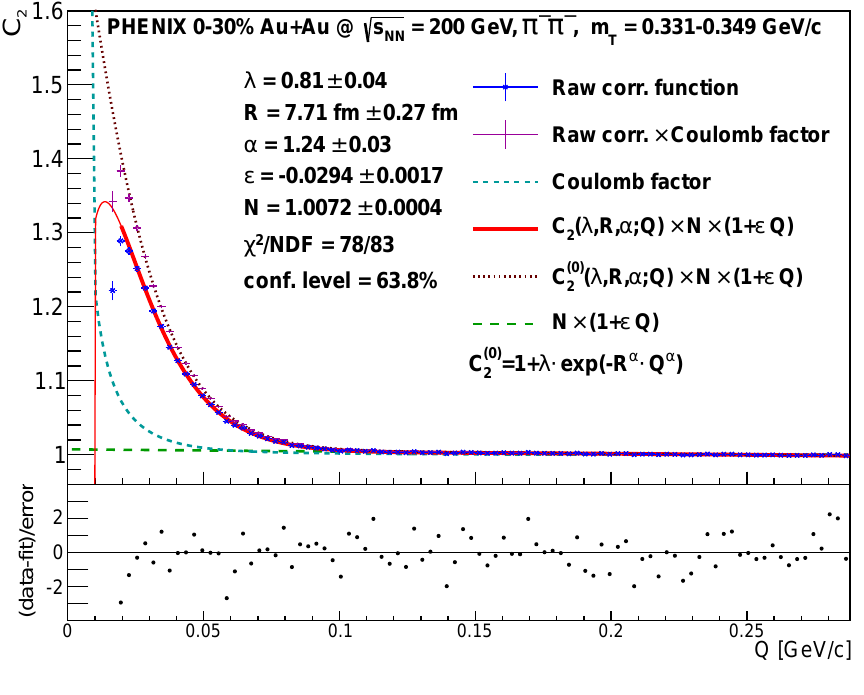
Figure 1. Example fit of π − π − pairs with m T between 0.331 and 0.349 GeV/c (corresponding to K T ∈ [ 0.3,0.32 ] GeV/c), measured in the longitudinal co-moving frame. The fit shows the measured correlation function and the complete fit function, while a “Coulomb-corrected” fit function C ( 0 ) ( Q ) is ( 0 ) also shown, with the data multiplied by C / C Coul 2 2